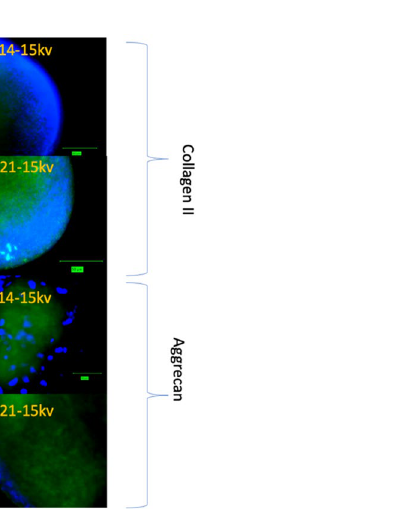
Figure 3. Sox9 and safranin O staining of 10 kV, 15 kV, and control of one single spheroid. The dishes were counterstained with DAPI (blue).